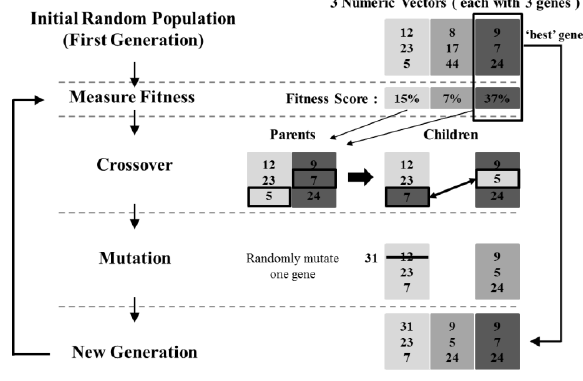
Figure 2. Example iteration of GA with a population of three numeric vectors [54].